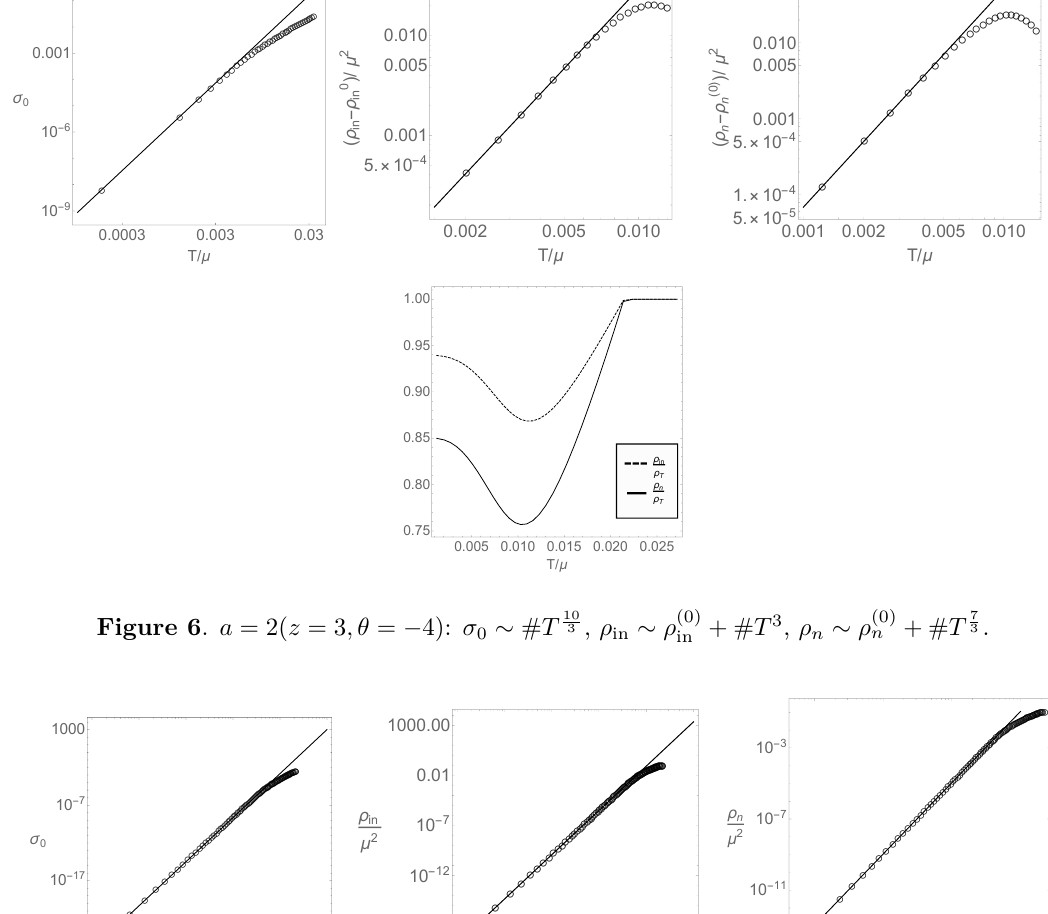
Figure 6 . a = 2( z = 3 , θ = − 4) : σ 0 ∼ # T 10 3 , ρ in ∼ ρ (0)